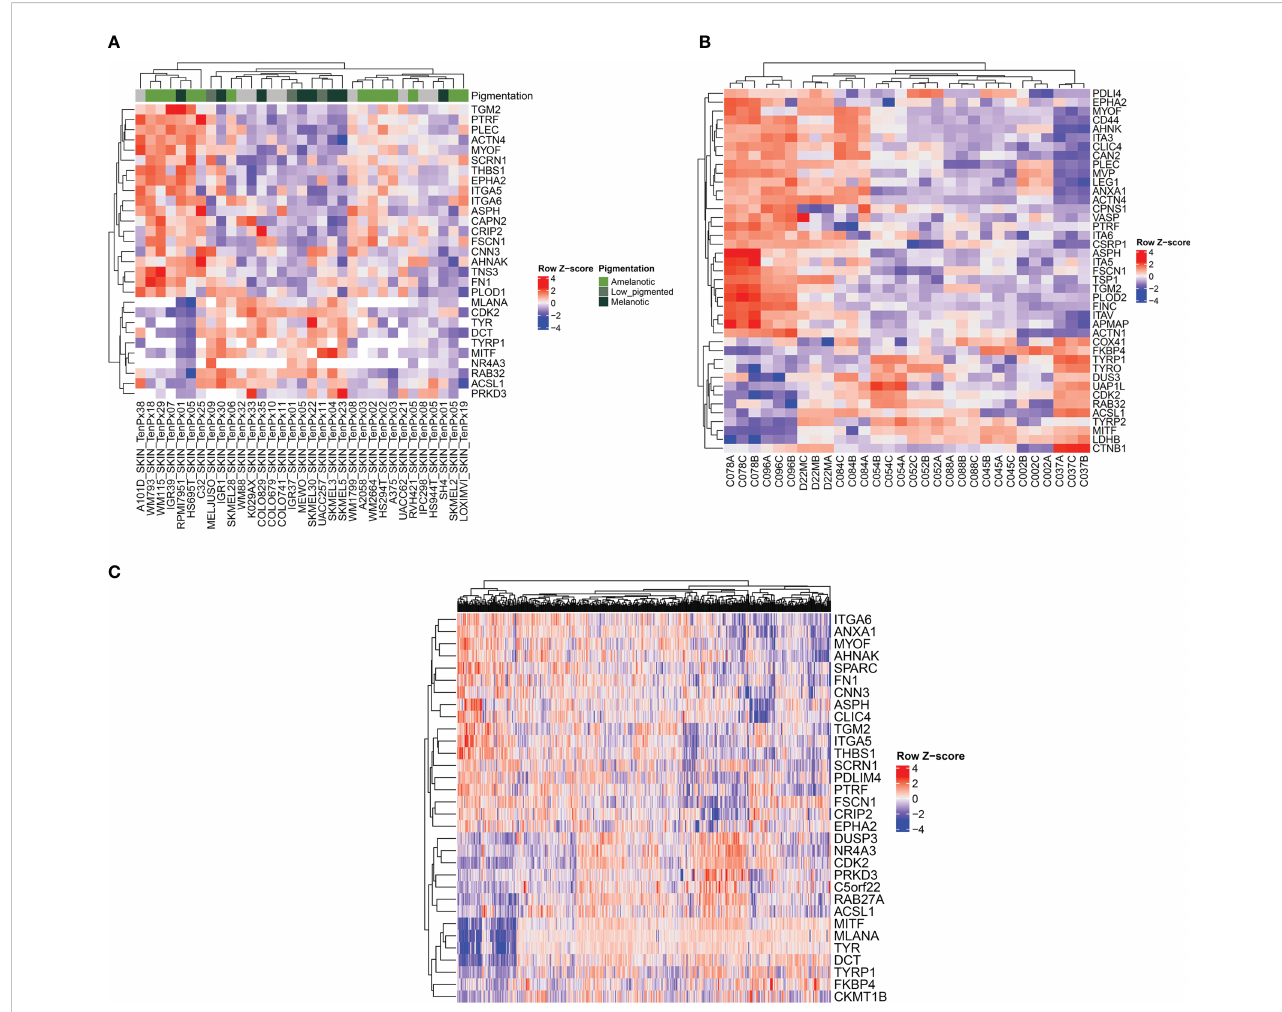
FIGURE 6 Heatmap representations showing the relationship between melanogenetic proteins and selected proteins identi fi ed in this study. The analysis was conducted on three different public datasets. (A) Heatmap of z-score of normalized protein expression values for selected proteins identi fi ed in 33 melanoma cell lines (52). (B) Heatmap of z-score of normalized protein area (log2) for selected proteins. Three biological replicates isolated from patients with melanoma are represented (53). (C) Heatmap of RNA-seq expression z-scores (RSEM z score) for selected protein-coding genes of 442 melanoma patients